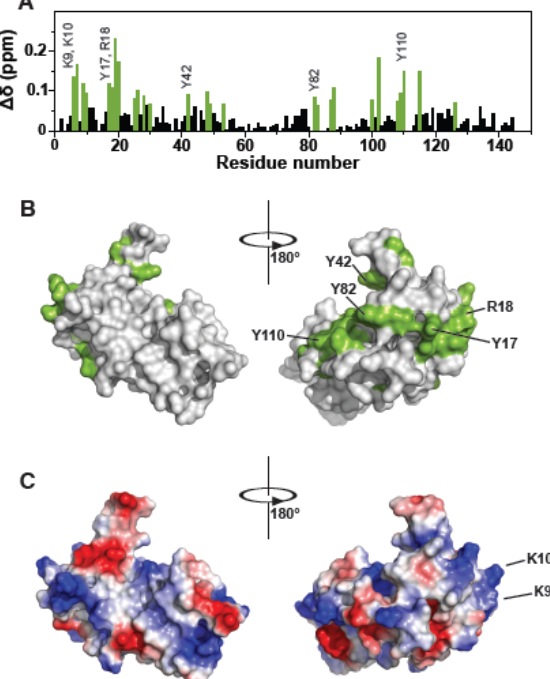
Figure 1. Yeast tRNA binds to Tsg101 UEV domain. ( A ), Residue-specific chemical shift perturbations of Tsg101 UEV upon binding to yeast tRNA (1:1). ( B ), Large perturbations ( > 1.5 s.d. from zero) are highlighted in green on a surface (grey) representation of the UEV (PDB ID: 1KPP; [42]). ( C ), Distribution of negative (red) and positive (blue) charges on a surface representation (grey) of the UEV domain (PDB ID: 1KPP; [42]).